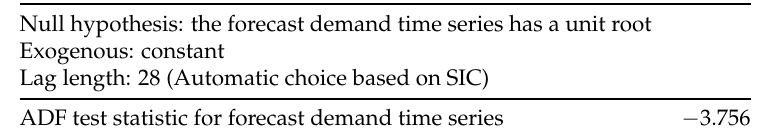
Table A2. ADF test for the forecast demand time series.